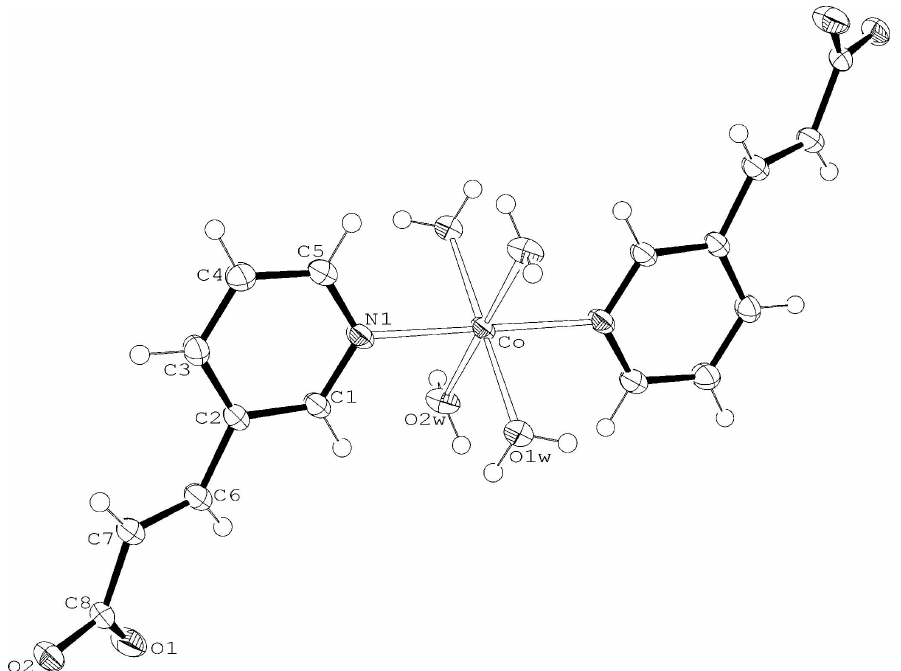
Figure 1 The molecular structure of the title molecule, with the atom-numbering scheme. Displacement ellipsoids are drawn at the 50% probability level